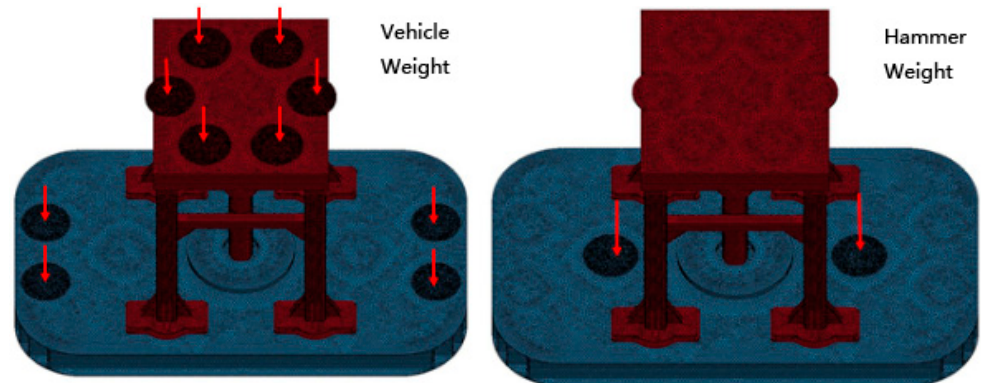
Figure 6. Vibrator loading diagram.